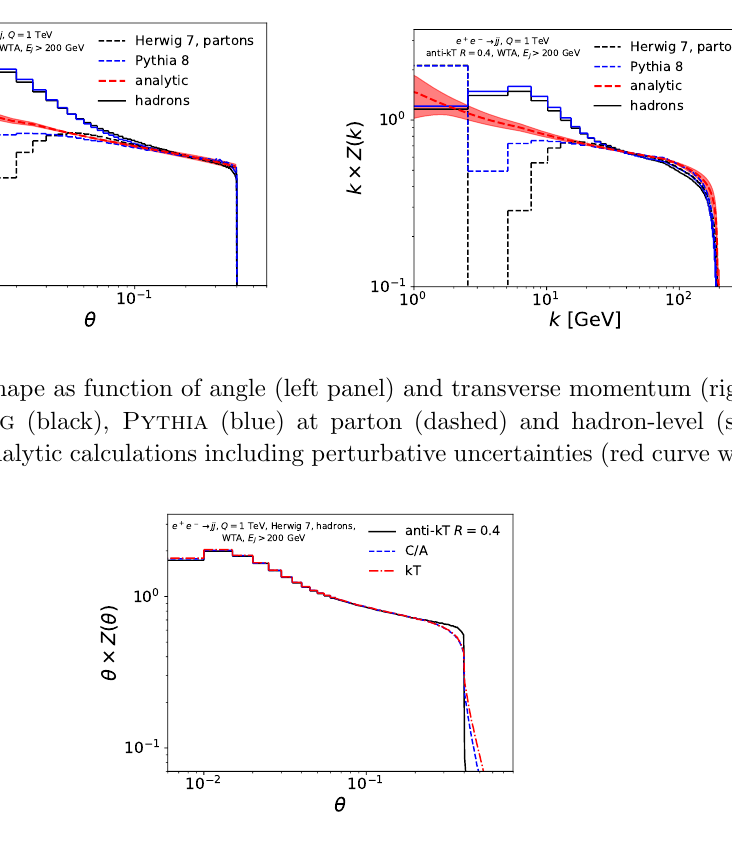
(cid:0) anti-k T (black),